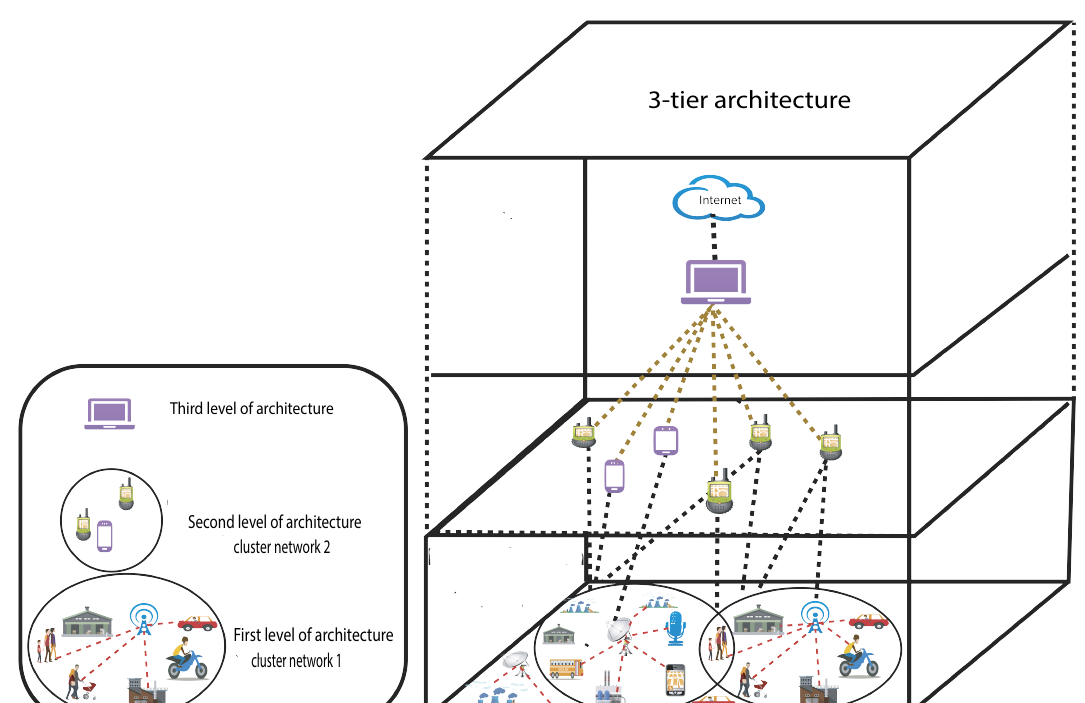
Figure 3. Multi-level network model for a big data collection application in a smart